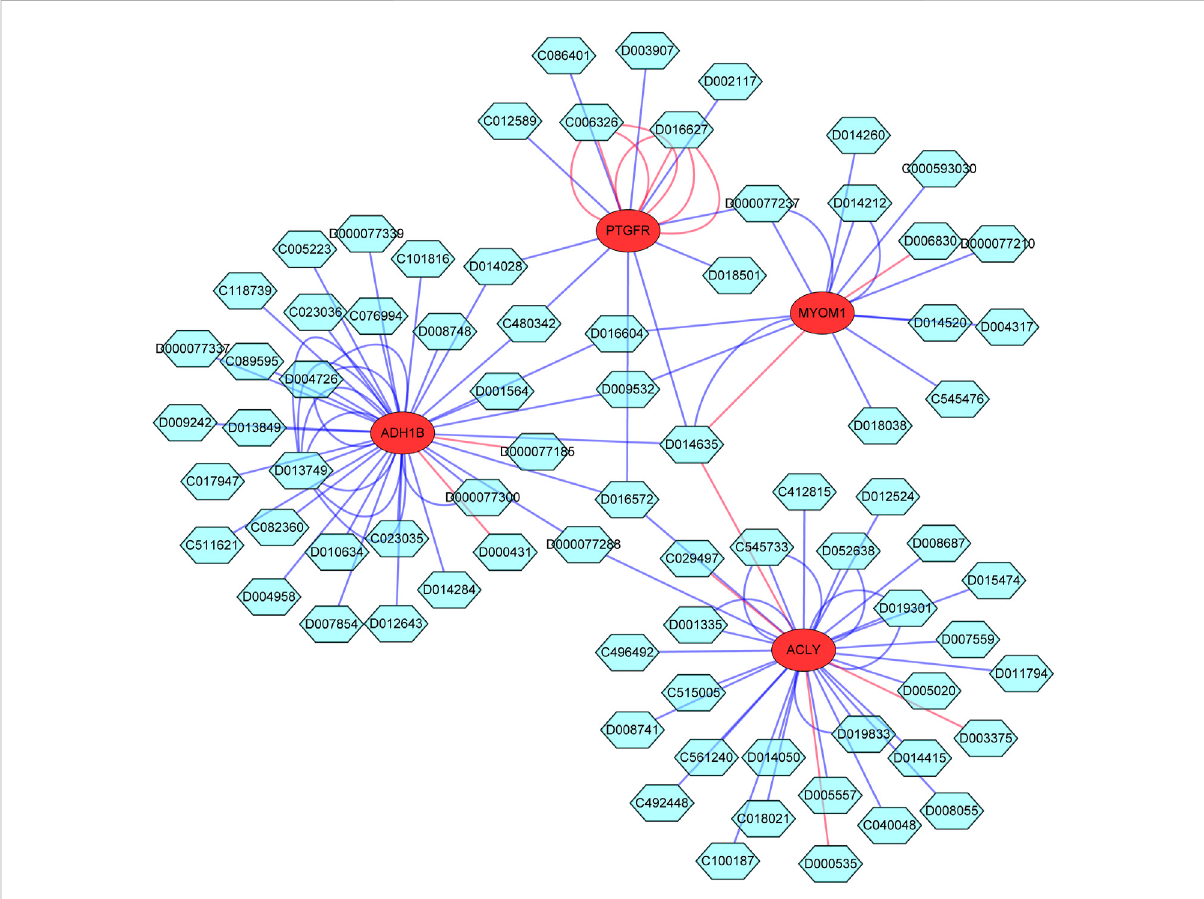
FIGURE 9 The Potential drugs targeting the characteristic genes. The red circle indicates mRNA; The blue green hexagon indicates drugs; The line color indicates different in fl uence effects, red indicates increased expression, and blue indicates decreased